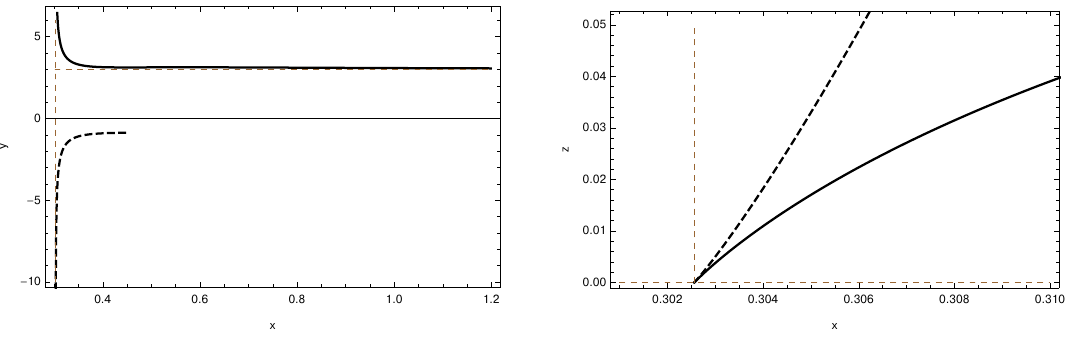
p Figure 6 . n CFT m model with m= 2 B = 1 is used to highlight phases of the anisotropic plasma. Following (1.3) we evaluate the constant- B speci(cid:12)c heat of the plasma. The dashed brown lines highlight the location of the critical point. Left panel: the speci(cid:12)c heat diverges as one approaches the critical temperature; it is negative for the branch denoted by the dashed black curve (see also the right panel of (cid:12)gure 5), indicating the thermodynamic instability. Right panel: ( c B =s ) (cid:0) 2 vanishes at criticality, with nonvanishing slope. This implies that the critical exponent (cid:11) = 1 , see (1.11). 2